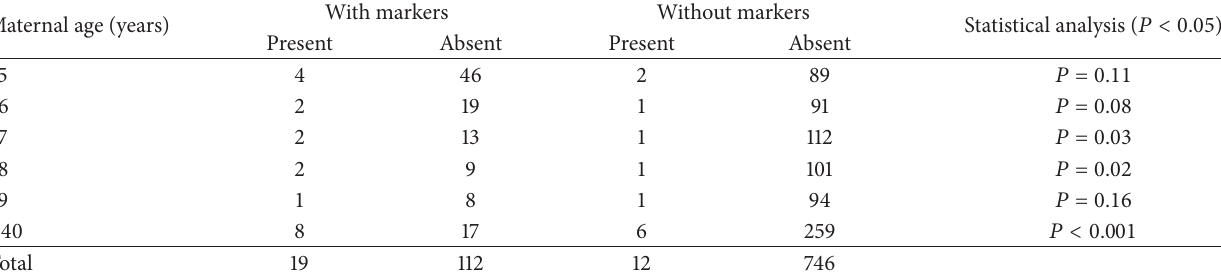
Table 2: Distribution of the cases of Down syndrome according to maternal age and ultrasound